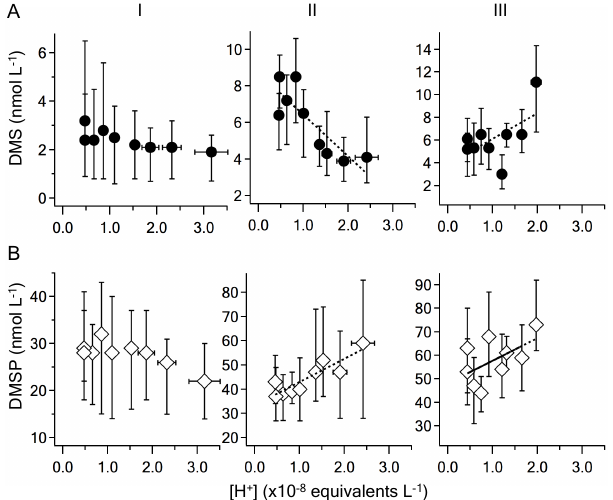
Fig. 3. Relationships between (A) DMS and (B) DMSPt and H + concentration ([H + ]) during each phase (I–III) of the experiment. Values are the mean over the duration of each phase in the nine mesocosms. Bars show the range. Significant linear regressions based on the full dataset of daily values are shown; details of which are given in Table 1. Note [H + ] decreases over the duration of the experiment in the mesocosms with higher initial concentration.